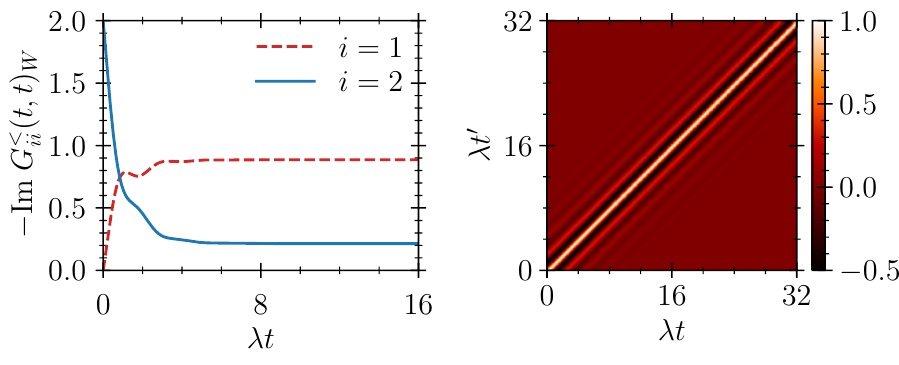
( t ) ˆ a ( t ) 〉 = − Im G < i i = 1.0 and N = 0.1 and initial conditions 1 2 + G < ( 0,0 ) . The tolerances are atol=1e-6 ij ij